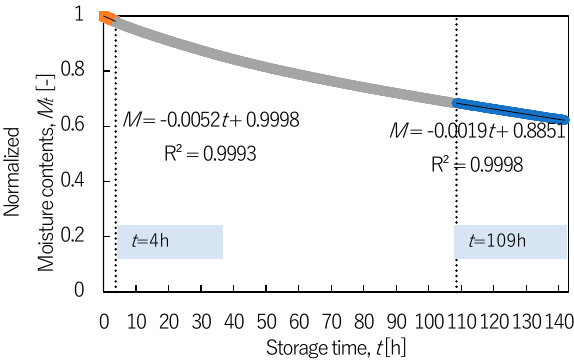
(C)The relationship between moisture and LE Fig. 8 Moisture contents and Light Elements (LE). 691